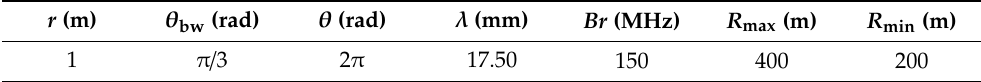
Table 2. Experiment parameters.